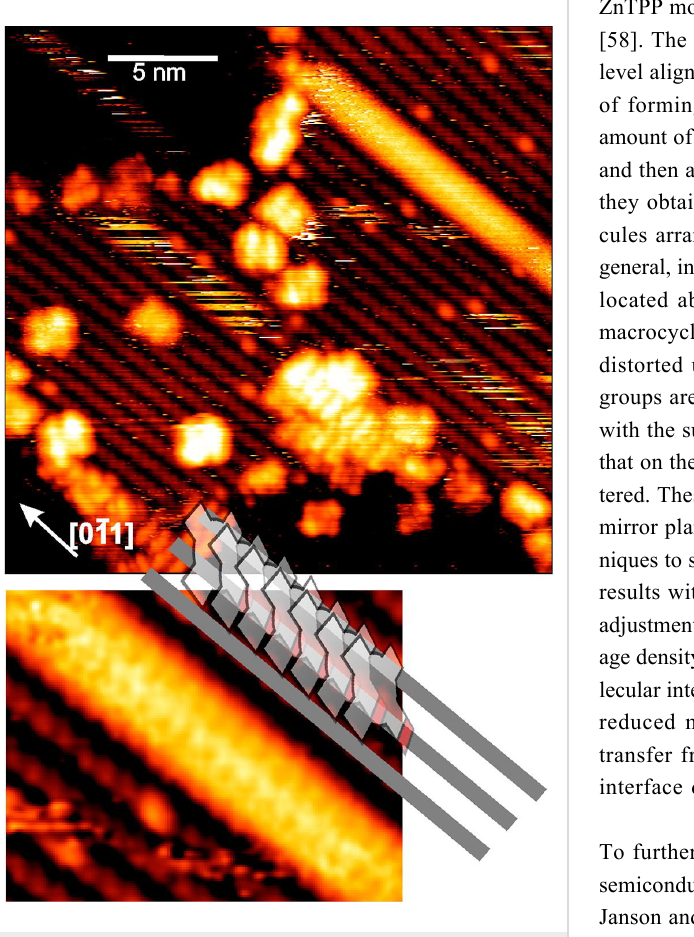
Figure 5: A linear π – π -stacked structure formed by COOH-ZnTPP molecules on a TiO 2 (011)-(2 × 1) surface – see in the upper right corner of the main image. The lower panel is a detailed view of the 1D line together with a scheme of the proposed molecular organization in the assembly. The figure has been adapted with permission from [56], copyright 2015 American Chemical